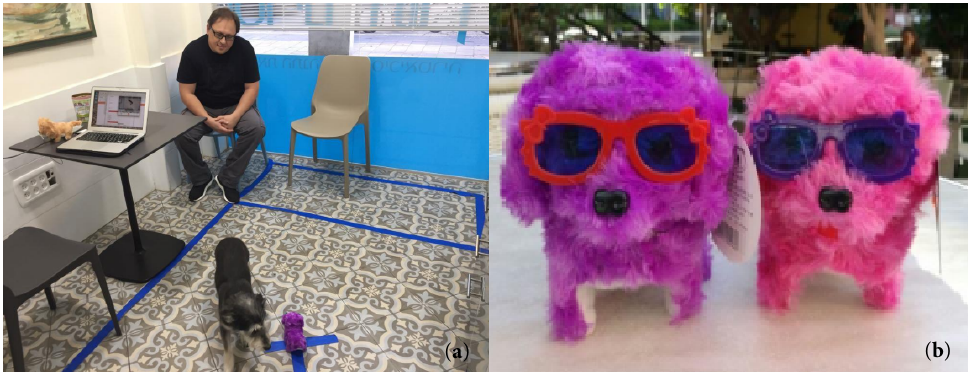
Figure 3. ( a ) Owner and his dog in consultation room in Tel Aviv Clinic. ( b ) Dog-shaped toys used in the experiment. Photos from earlier research capturing video recordings used for the present work [38].